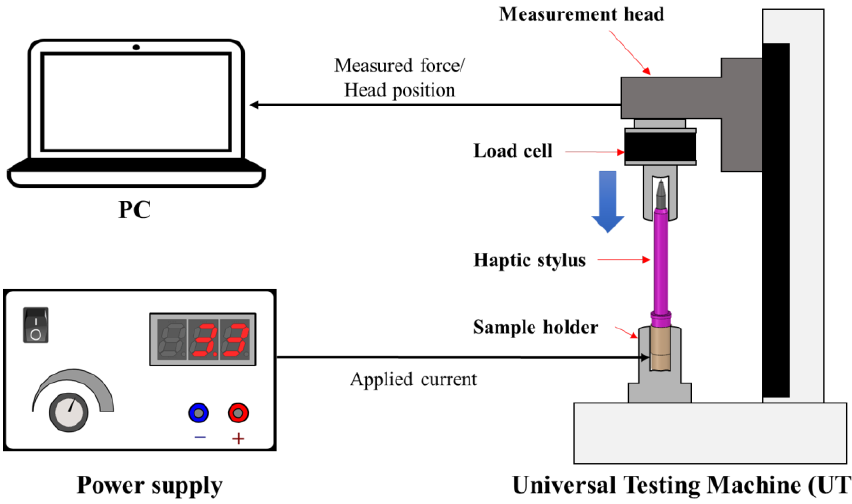
Figure 8. Experimental setup to evaluate the haptic performance of a proposed tiny haptic